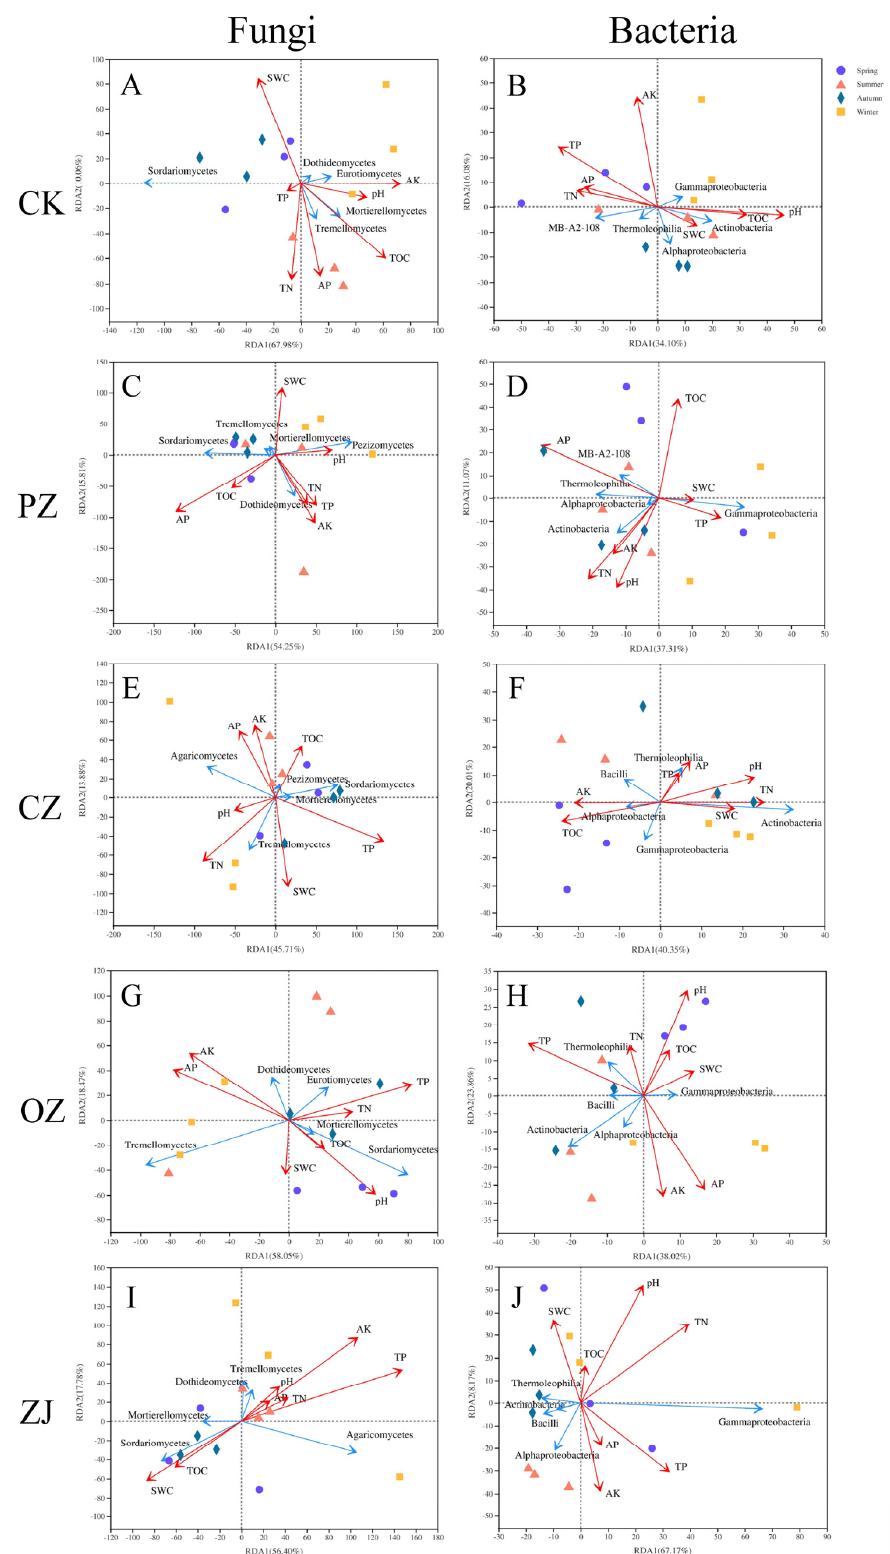
Figure 6. Redundancy analysis (RDA) of the top five fungal and bacterial classes with soil proper ties. RDA of top five fungal classes with soil properties of CK ( A ), PZ ( B ), CZ ( C ), OZ ( D ), and ZJ ( E ) samples. RDA of top five bacterial classes and soil properties of CK ( F ), PZ ( G ), CZ ( H ), OZ ( I ), and ZJ ( J ) samples. CK: control; PZ: C . heterophylla ; CZ: C . kweichowensis ; OZ: C . avellane ; ZJ: C . heterophylla × C . avellane